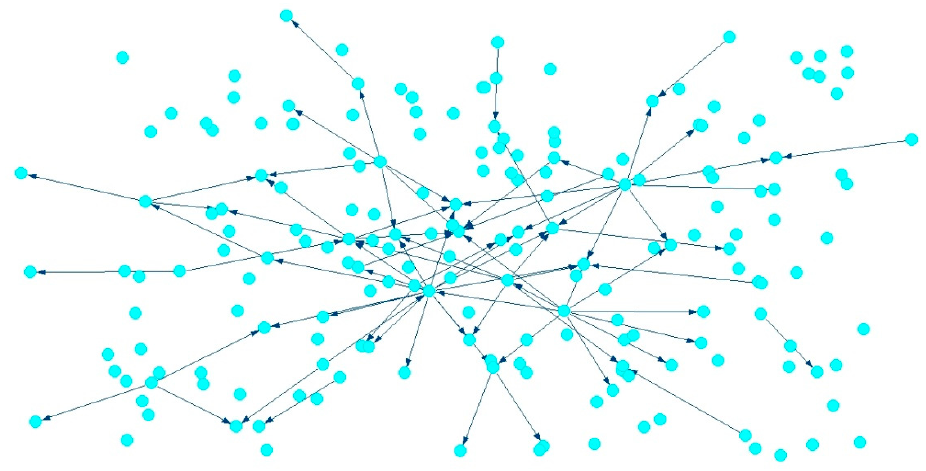
Figure 3. Citation network of 192 papers.